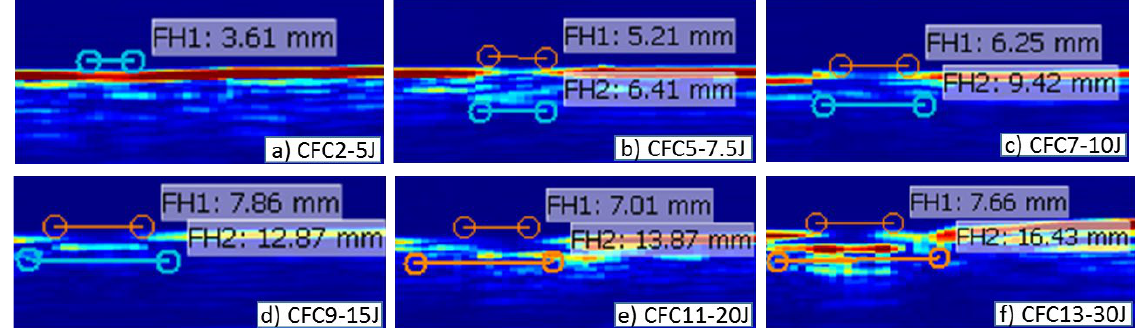
Figure 1. Damage characterisation B-Scans—Carbon Fibre—5 J to 30 J ( a – f ).